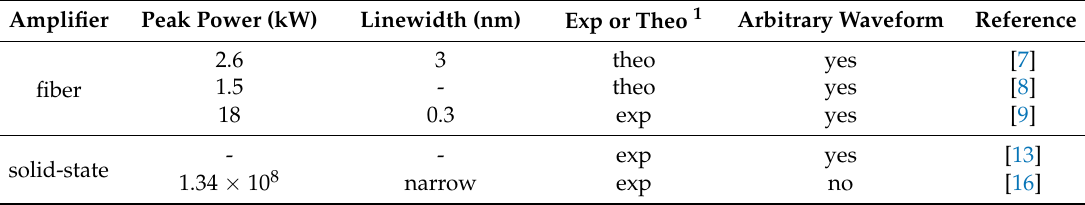
Table 1. Progress in temporal compensation for saturated